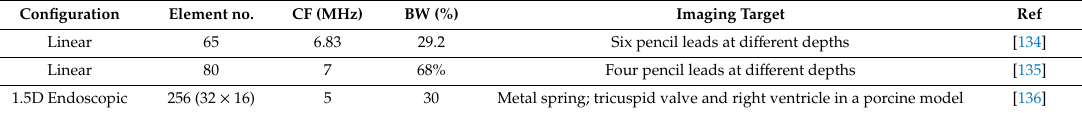
Table 4. Di ff erent configurations of PMUT that have been used in photoacoustic imaging applications.